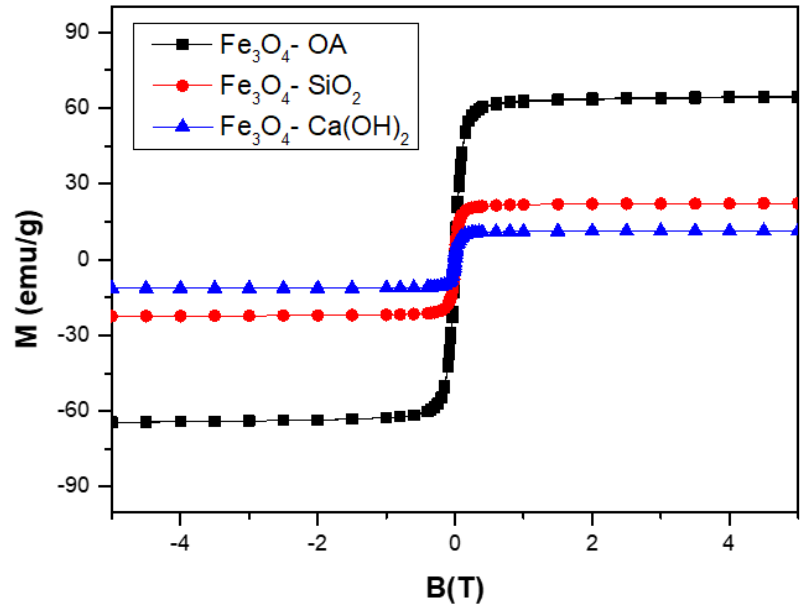
Figure 2. Hysteresis loops at room temperature of Fe 3 O 4 -OA, Fe 3 O 4 -SiO 2 , Fe 3 O 4 -Ca(OH) 2 particles.